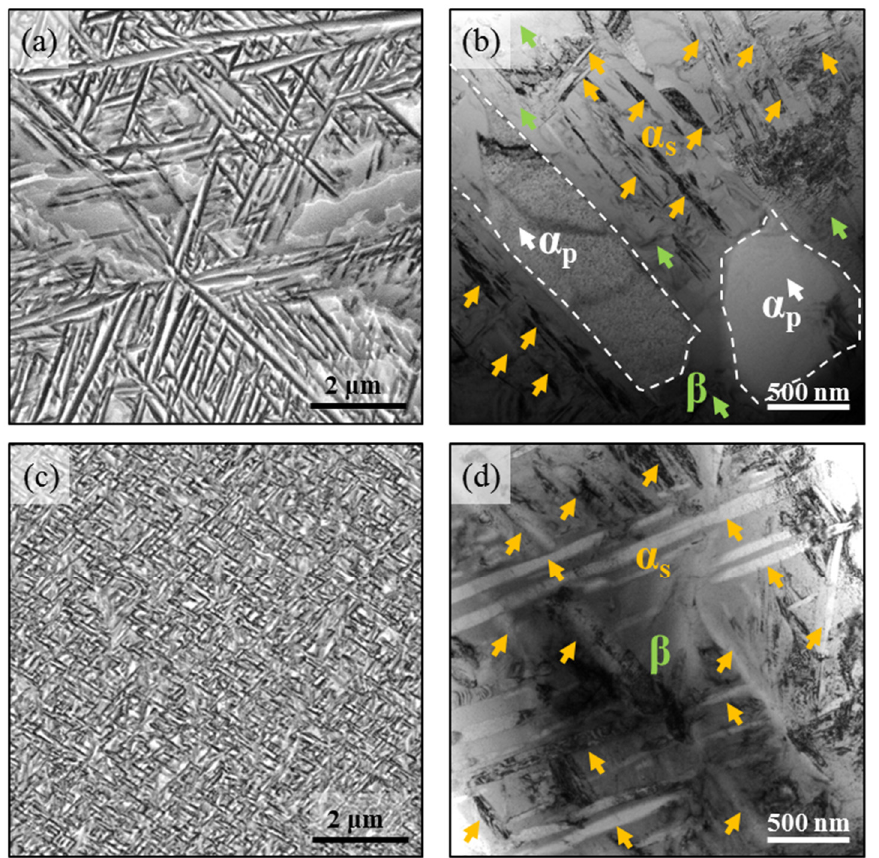
Figure 2. Typical microstructures of Ti-45551 alloy after different heat treatment. ( a , b ) Ti-45551 al- loy after being aged at 360 °C for 8 h; ( c , d ) Ti-45551 alloy after being aged at 360 °C for 8 h + aged at 550 °C for 8 h. The yellow arrows represent α s, green arrows reprensent β and white arrows represent α p .